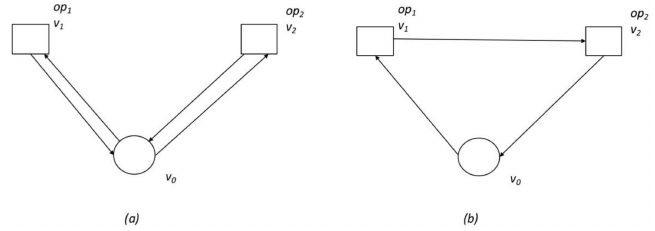
Figure 4. Example of routes between